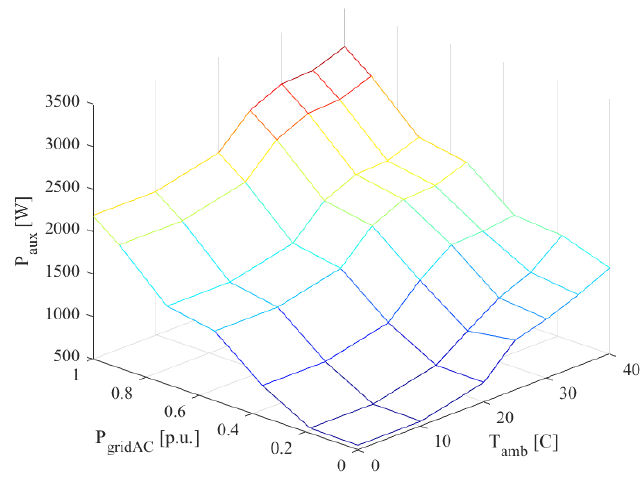
Figure 12. Auxiliaries' power.